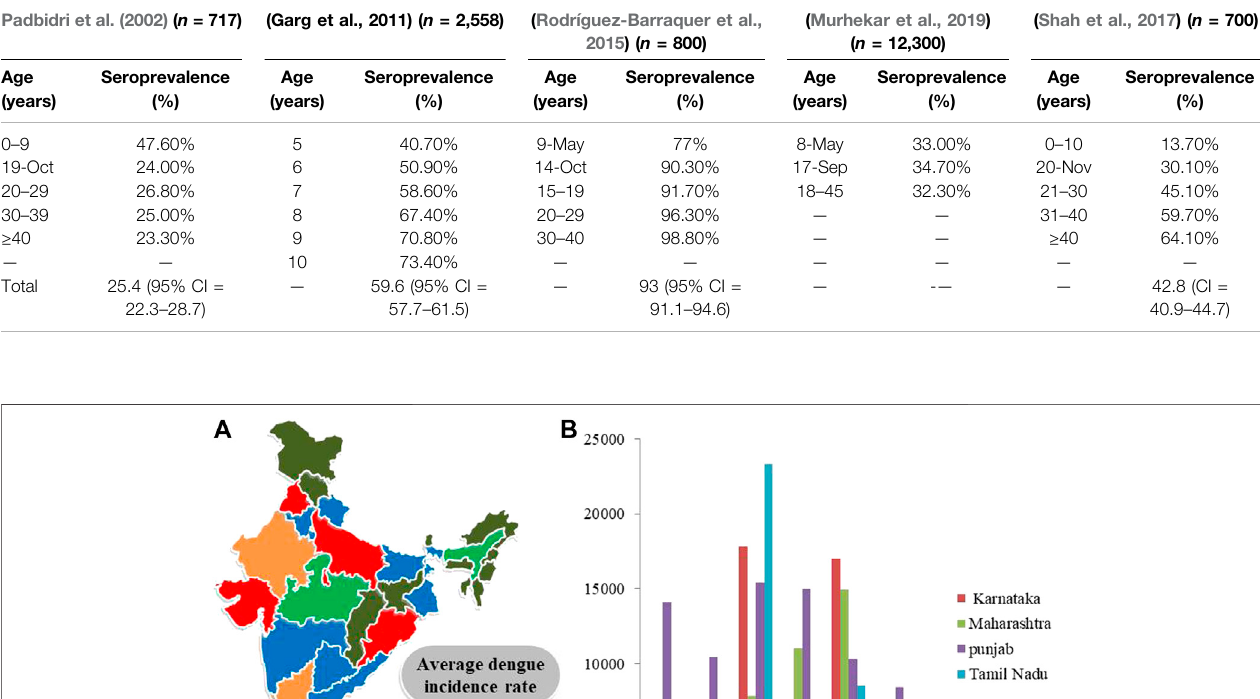
Frontiers in Pharmacology |